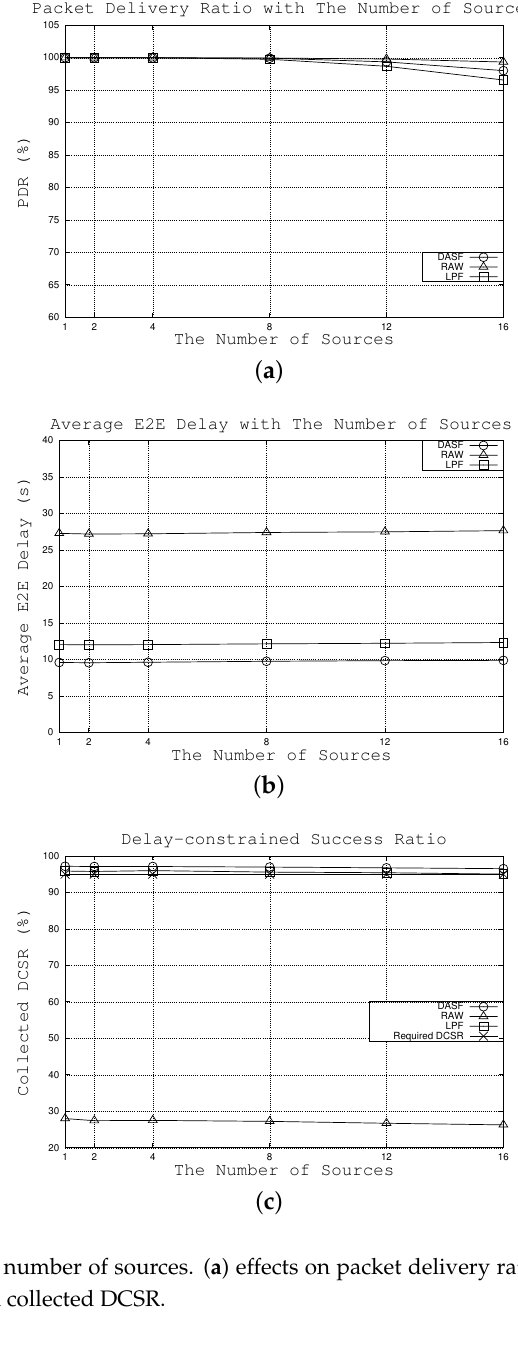
Figure 8. Effects of the number of sources. ( a ) effects on packet delivery ratio, ( b ) effects on average E2E delay, ( c ) effects on collected